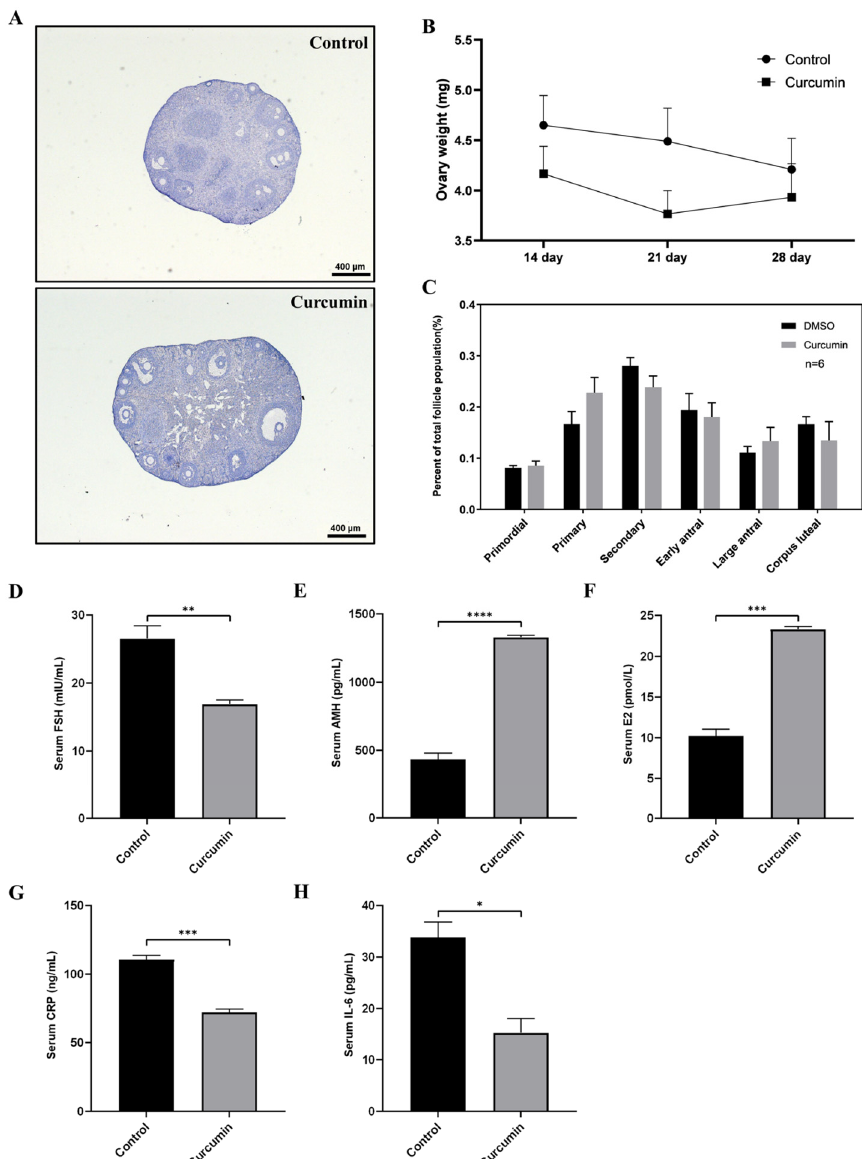
Figure 3. The effect of curcumin on aged mice. ( A ) Histology of ovaries after ip injection of curcumin in aged mice. ( B ) The weight of the ovaries of aged mice at different time points. ( C ) The follicle counts in aged mice. ( D – H ) Expression levels of reproductive hormones and inflammatory factors in the serum of aged mice. * p -value < 0.05, ** p -value < 0.01, *** p -value < 0.001, **** p -value < 0.0001 compared to the